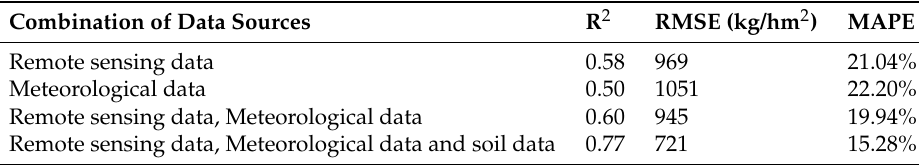
Table 2. Model accuracy using different combinations of data